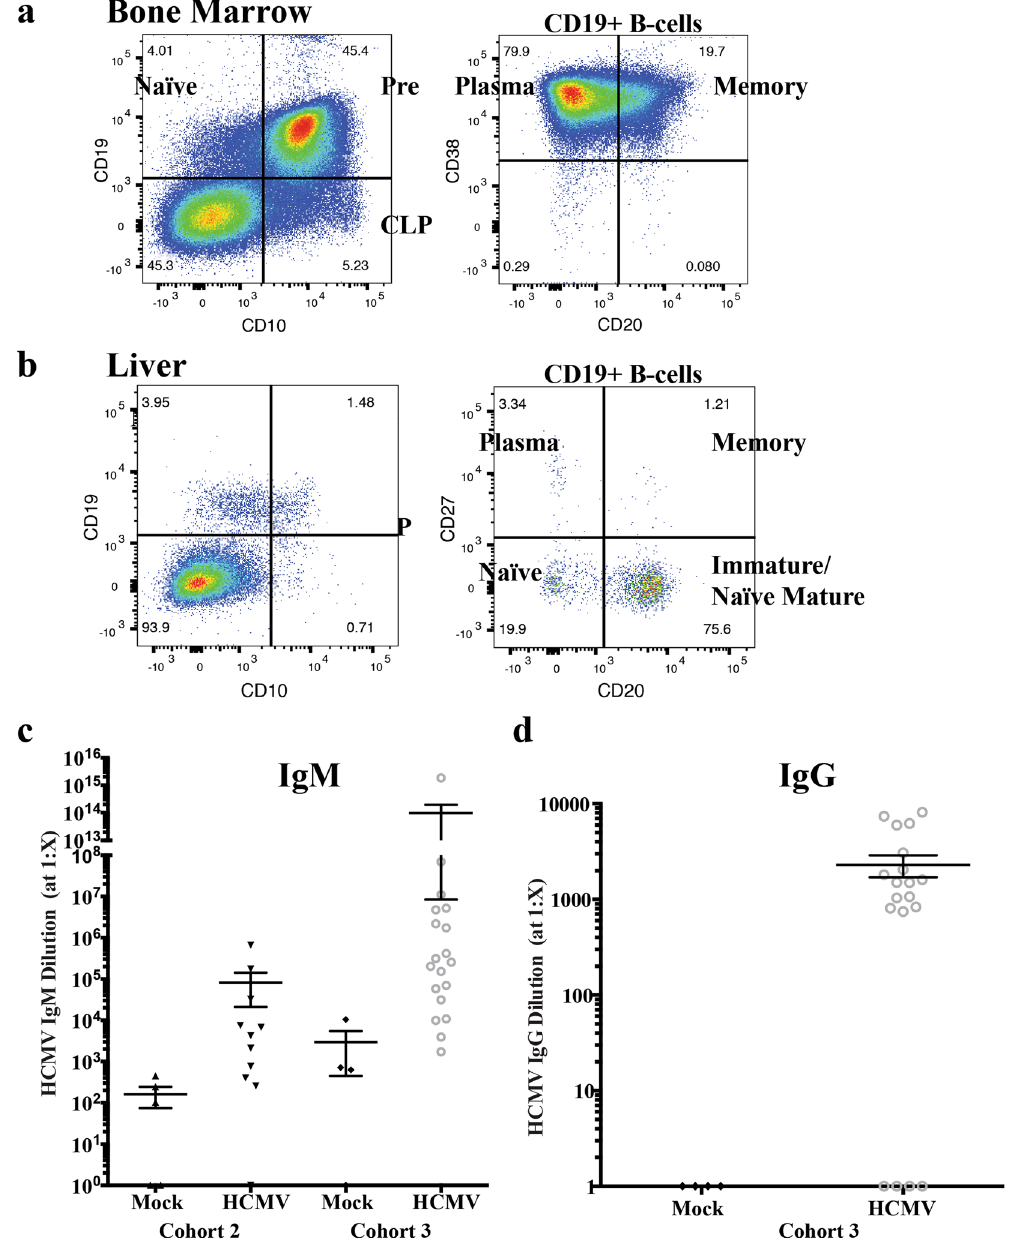
Figure 6. huBLT mice develop mature human B-cells and functional HCMV-specific antibody responses. huBLT mice were generated as described in Fig. 1. Total mononuclear cells from the bone marrow ( a ) and liver ( b ) from an uninfected huBLT mouse at 17 weeks post-humanization were analyzed by flow cytometry for human B-cell subsets. Samples were gated on total viable, murine CD45-, human CD45 + lymphocytes. Both organs were analyzed for B-cell maturation looking at CD10 + CD19- committed lymphoid progenitors (CLP, which are also CD38 + CD20 − ) and CD10 + CD19 + pre-B-cells and CD10-CD19 + naïve B-cells (panel 1). The CD19 + B-cell population was further analyzed for CD27-CD20- naïve B-cells, CD20 + CD27 − immature/ naïve mature B-cells, CD27 + CD20 + memory B-cells and CD27 + CD20 − plasma B-cells (panel 2). huBLT mice were generated and infected with HCMV as described in Fig. 1 and euthanized at 8 weeks post-infection. Plasma samples were analyzed by ELISA for HCMV antibodies using a pan-IgG/IgM/IgA secondary antibody. Positive samples were re-analyzed for antibody maturation using secondary antibodies specific for IgM ( c ) or IgG ( d